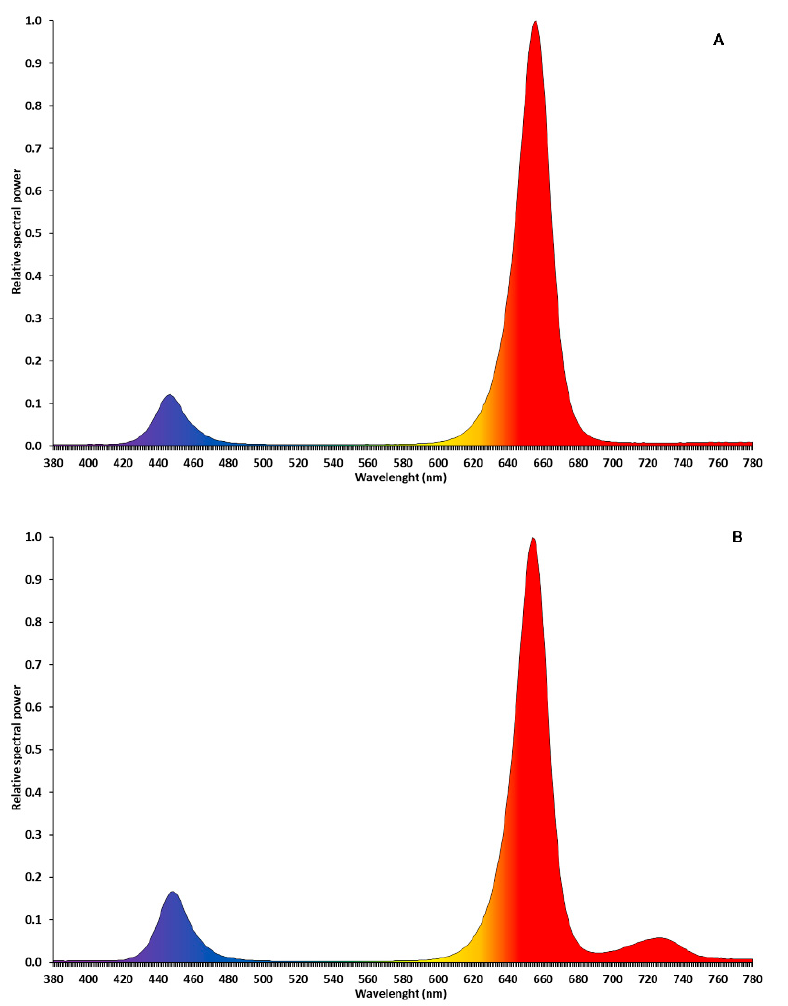
Figure 1. Relative spectral power of LEDs fixtures R + B ( A ) and R + B + FR ( B ). Light spectra were measured with spectrophotometer LI-180 (LI-COR, Lincoln, NE, USA).